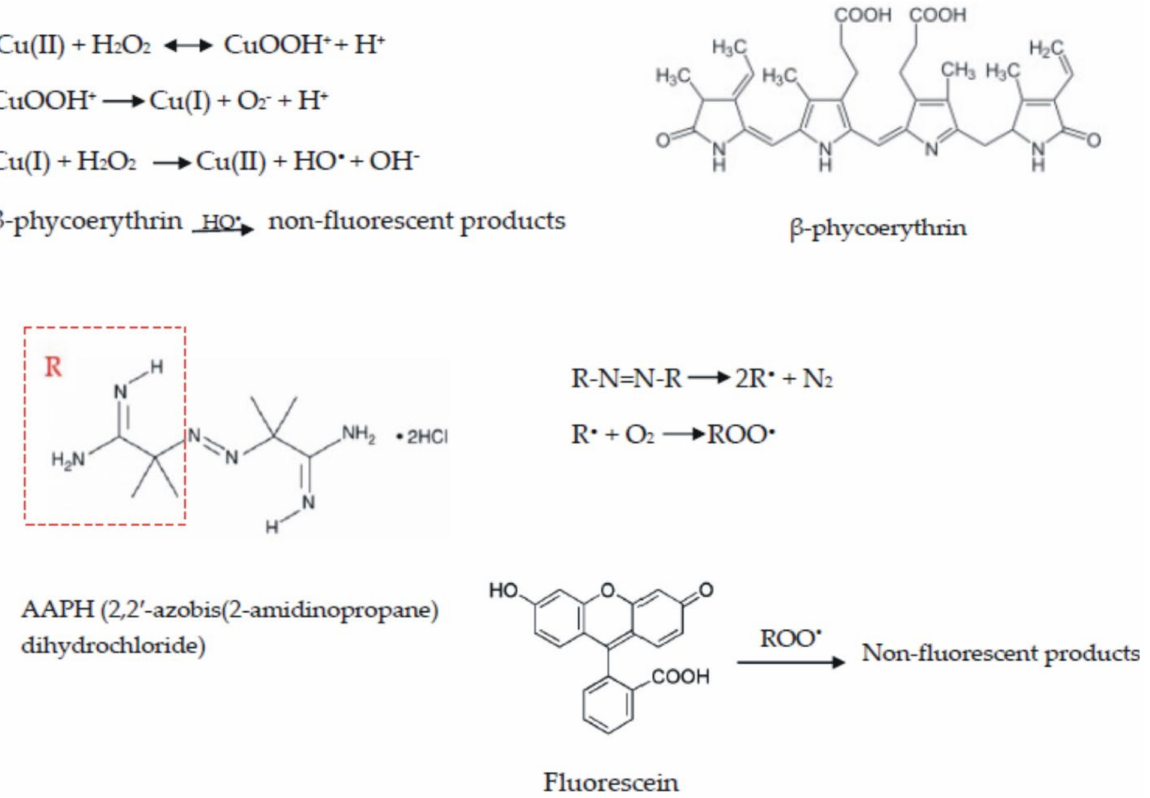
Figure 3. Reaction schemes involved in Oxygen Radical Absorption Capacity (ORAC) assay for the detection of hydroxyl and peroxyl